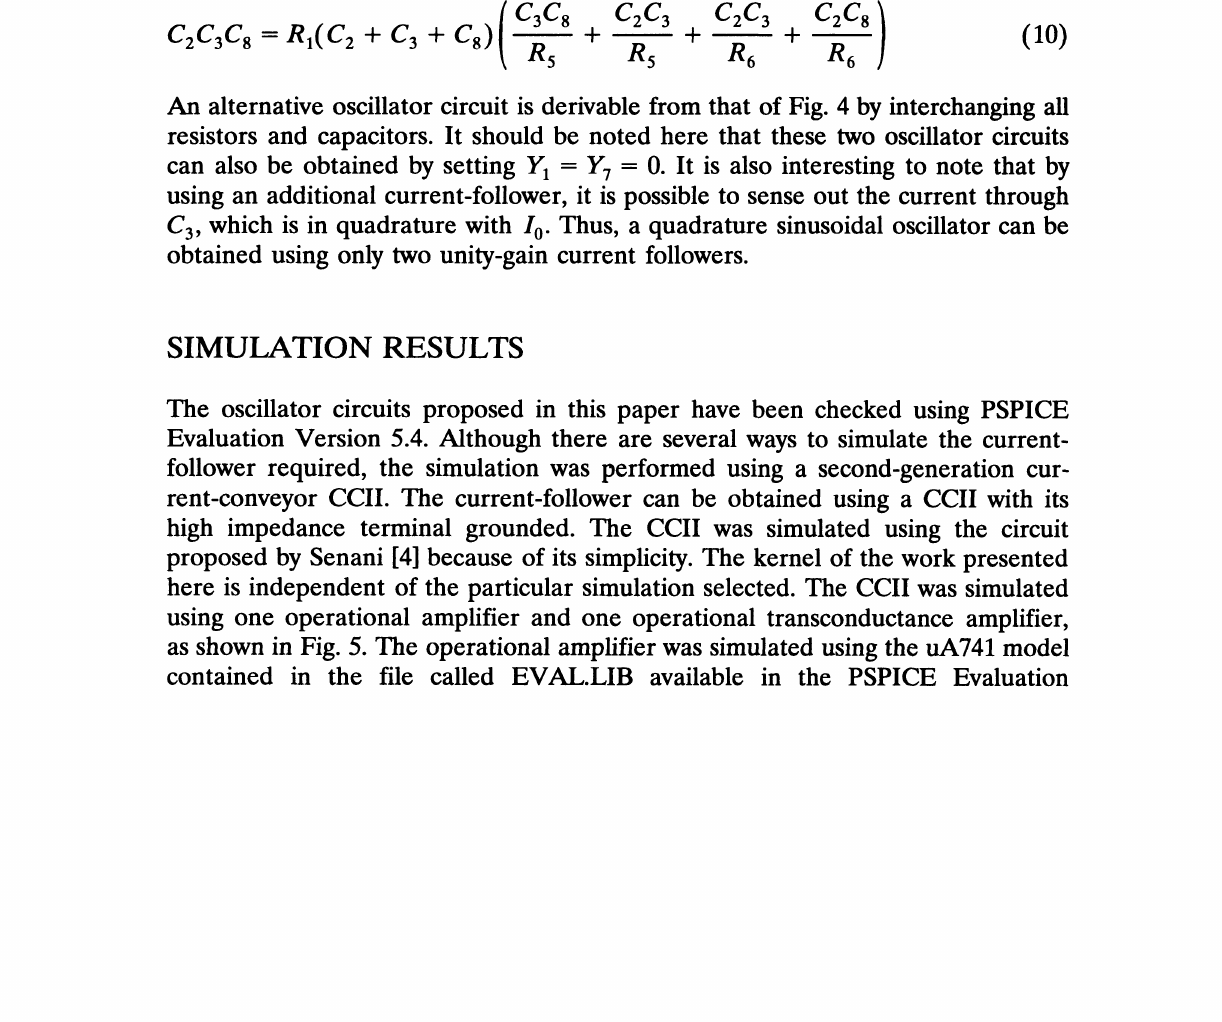
FIGURE 4 A proposed unity-gain-current-follower based oscillator circuit derived from Fig.